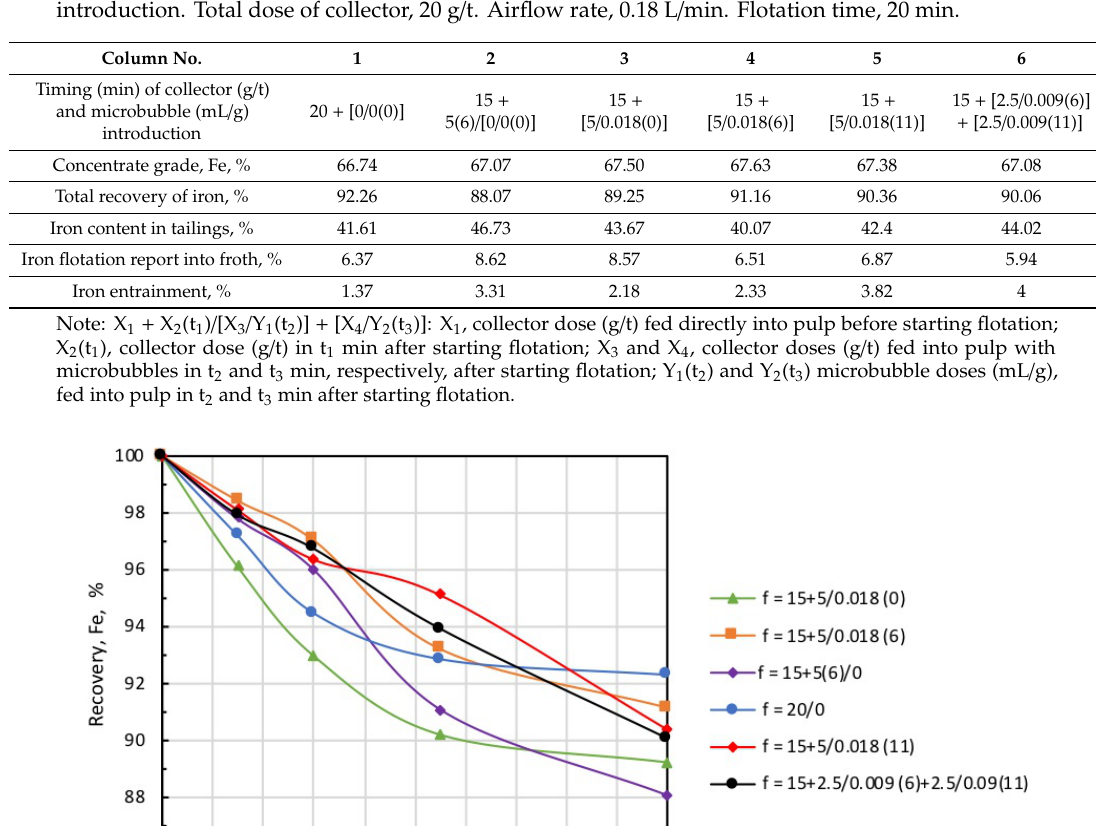
Table 3. Flotation of magnetite / Ballotini mixture at di ff erent modes of collector and microbubble